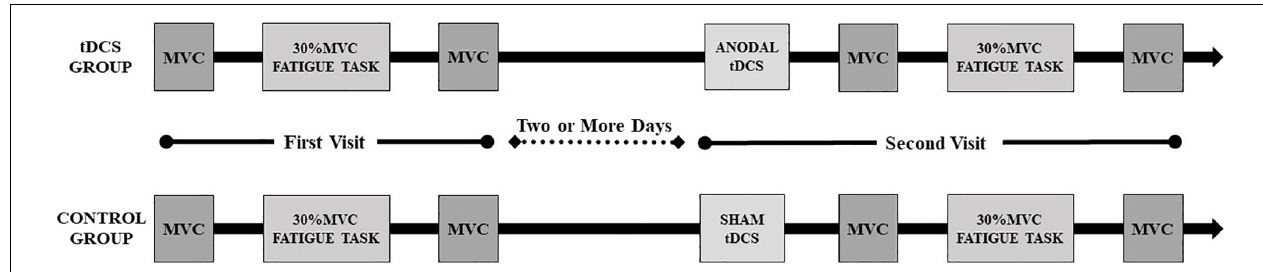
FIGURE 1 | Overall view of the experimental